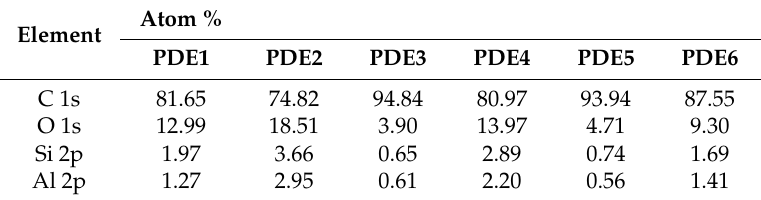
Table S2. XPS analysis of the fabricated PDEs using HB pencils from different boxes (1–6). Element